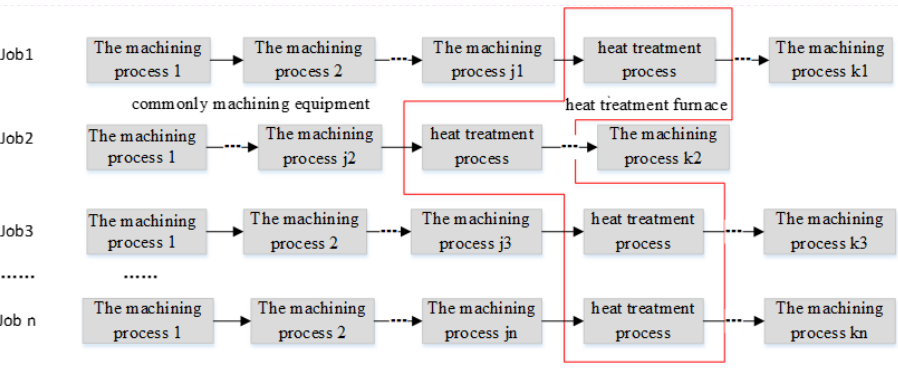
Figure 1. Processing Route for Mechanical Parts with Heat Treatment Process.